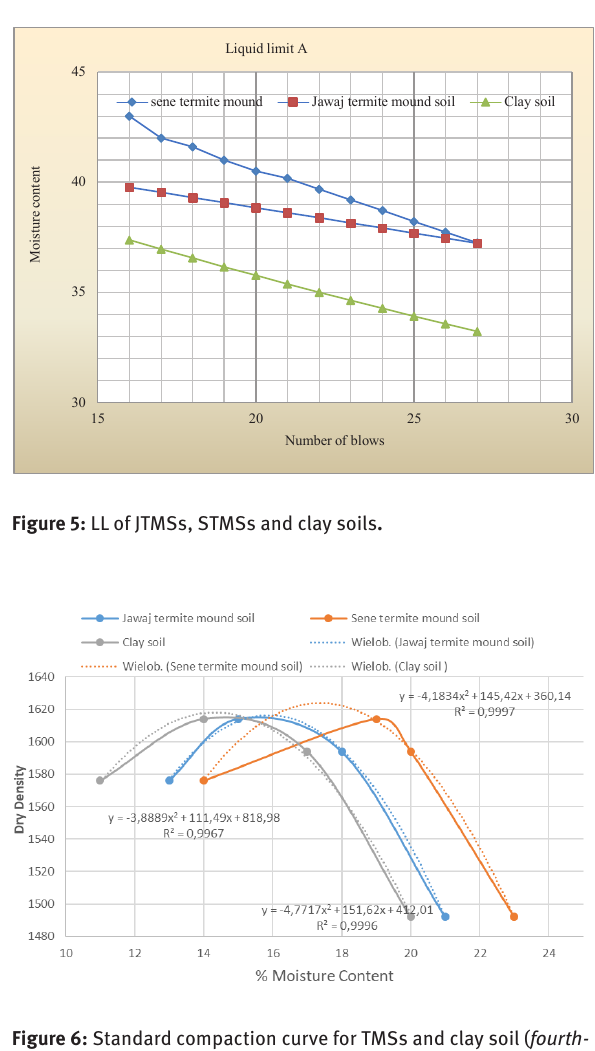
Figure 6: Standard compaction curve for TMSs and clay soil ( fourth- order polynomial was used to give better results than the tangent line approximation ).